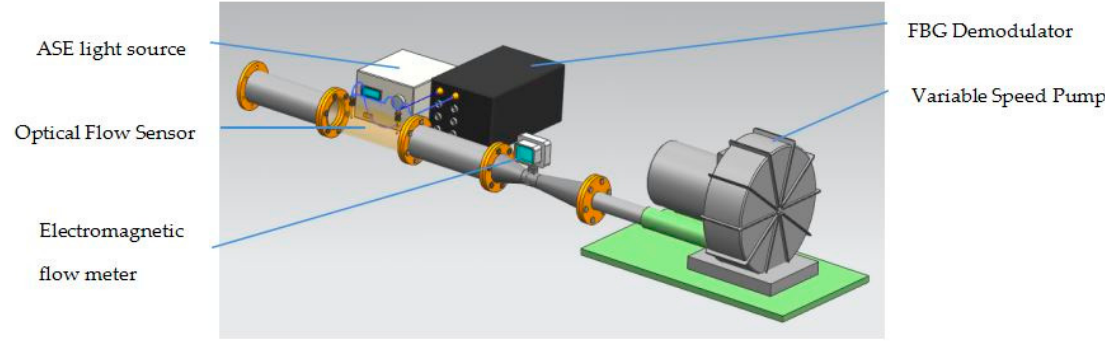
Figure 7. Diagram of the test system.